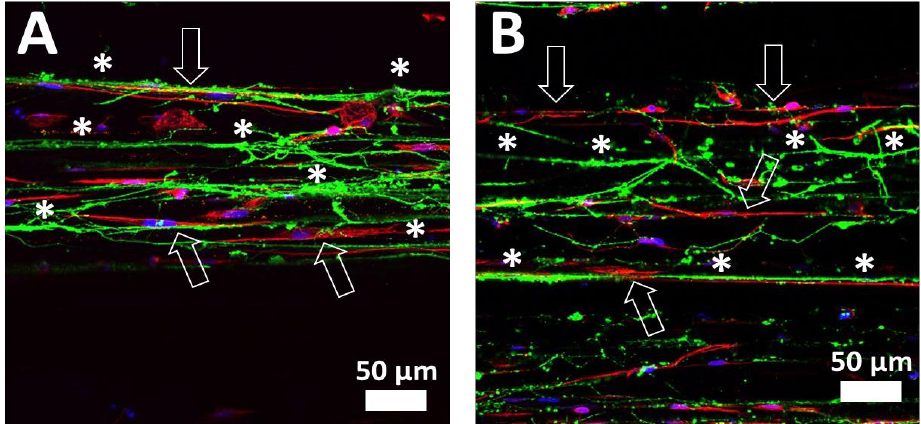
Figure 7. Confocal images of control ( A ) and electrically stimulated ( B ) samples. This confocal images in a region far from the DRG body allows to observe the axons (Neuron-specific β III Tubulin antibody in green colour) and the Schwann cells (S100 β antibody in red colour), as well as the cell nuclei (DAPI in blue colour). It can be observed how the axons grow in a highly aligned manner in the direction of the PLA-PPy microfibers (marked with *). Likewise, it is also observed that the cytoskeletons of Schwann cells are elongated in the direction of PLA-PPy microfibers (marked with arrows), accompanying the